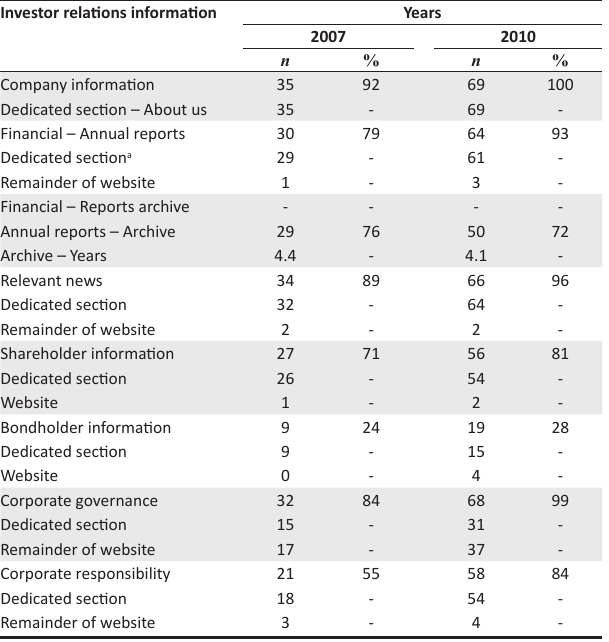
TABLE 3: Investor relations information communicated evaluated against the checklist. Investor relations